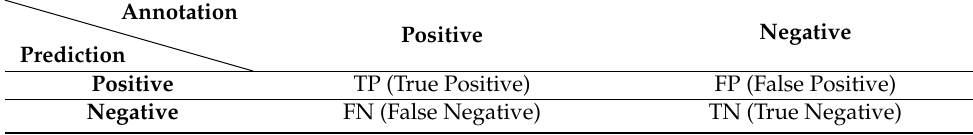
Table 1. The definition of the Confusion